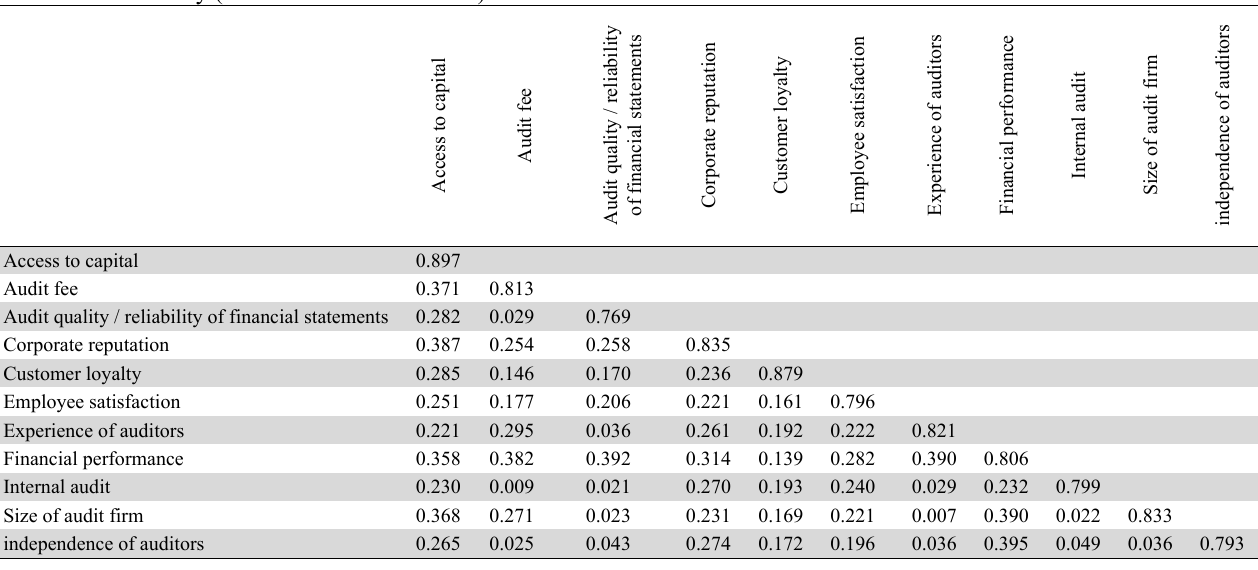
Discriminant Validity (Fornell-Larcker Criterion)